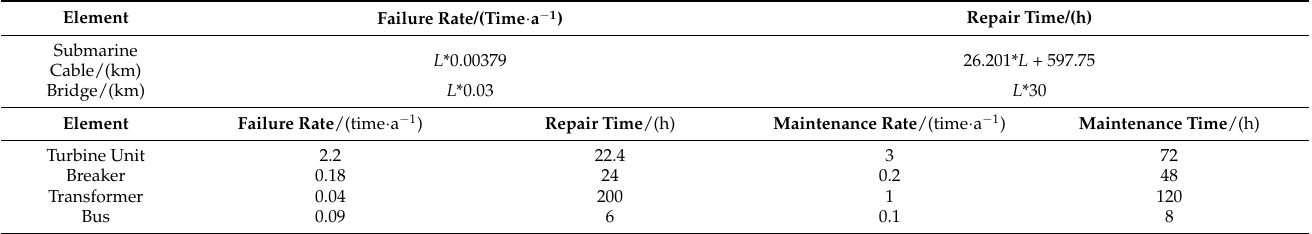
Table 4. Component reliability parameters.